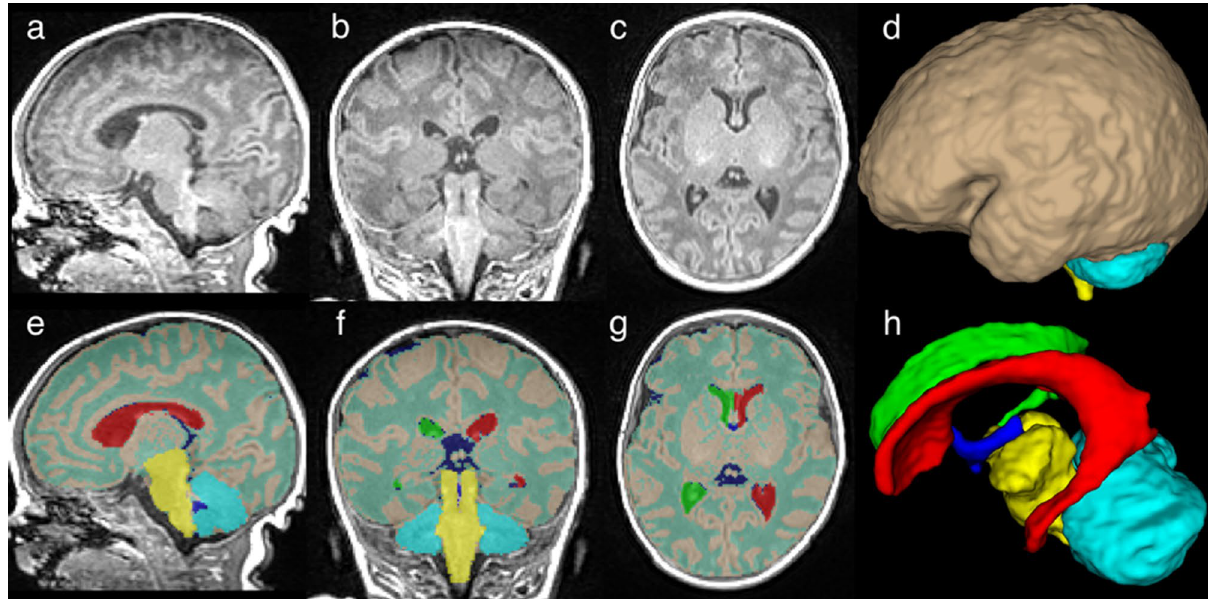
Figure 2. Manually segmented anatomical regions overlaid on a T1-weighted image. T1-weighted image with no overlay in sagittal ( a ), coronal ( b ), and axial ( c ) slices through the volume. Manually segmented anatomical regions overlaid on the same T1-weighted image in sagittal ( e ), coronal ( f ), and axial ( g ) slices through the volume. 3D renderings of the segmentations are shown in ( d ) and ( h ). Red label: left lateral ventricle. Green label: right lateral ventricle. Dark blue: 3rd and 4th ventricles. Yellow: brain stem. Cyan: cerebellum. Turquoise: white matter. Brown: grey